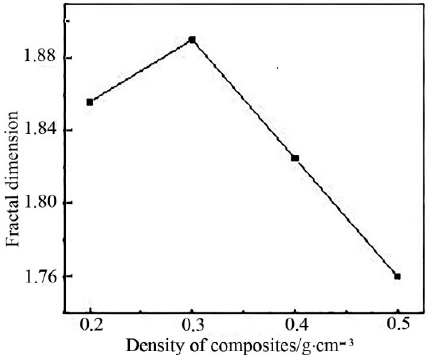
Figure 13. Relationship between fractal dimension and density of DFs composites.